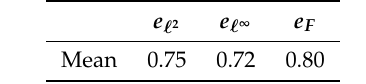
Table 6. Percentage error of the local stiffness matrix A K 0 c in experiment 2.